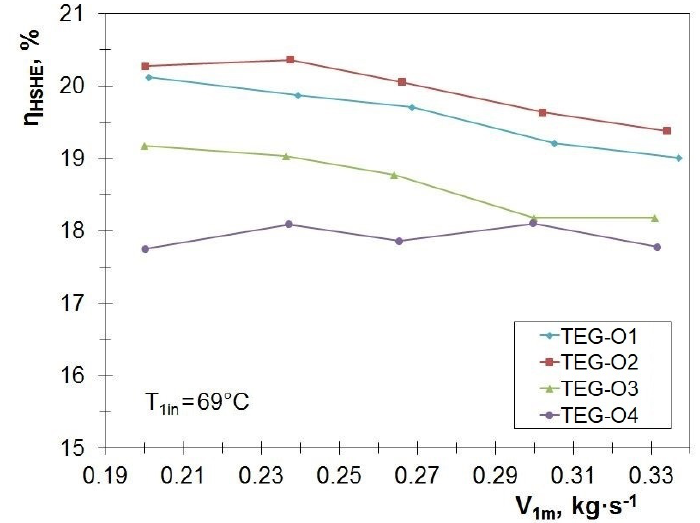
Figure 9. HSHE effectiveness for selected circulations at T 1 in = 69 ◦